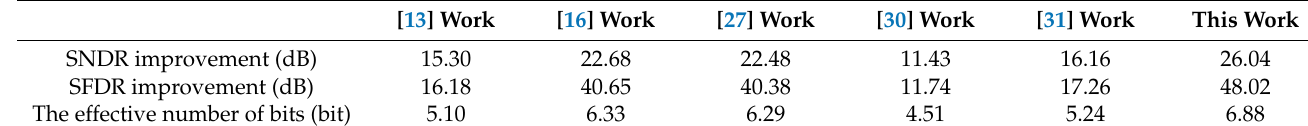
Table 6. Comparison of calibration effects in the ADC12DL3200EVM